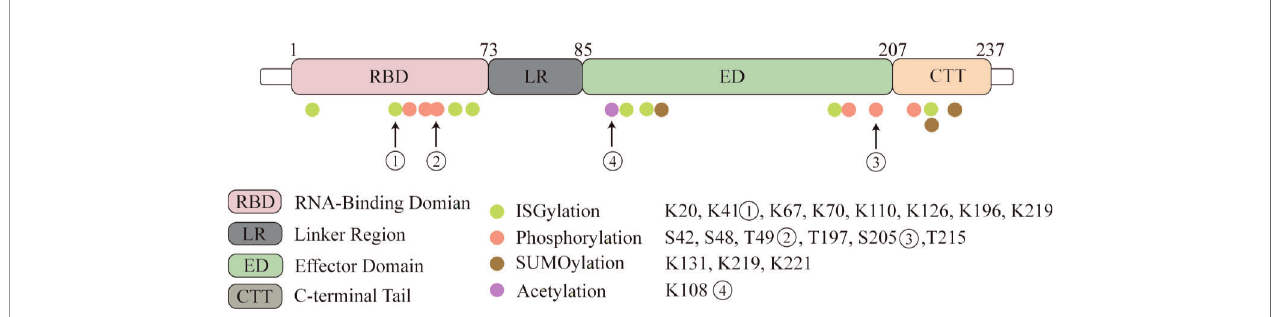
FIGURE 1 | NS1 protein undergoes post-translational modi fi cations. Four kinds of post-translational modi fi cations can be made to NS1, namely: ISGylation, phosphorylation, acetylation and SUMOylation. Here we highlight several important modi fi cation sites. Eight ISGylation sites have been reported, ① among which K41 is the main site of ISGylation, which disrupts the Interaction of the NS1 RBD with Importin- a . ② T49 position modi fi cation impairs the binding ability of NS1 to RIG-I, dsRNA and TRIM25 ternary complexes. ③ Phosphorylation modi fi cation of S205 enhances the binding ability to DDX21 and enhances polymerase activity. ④ Acetylation modi fi cation of this site possesses the ability to bind